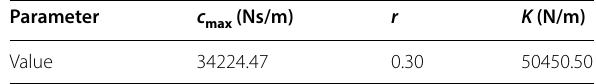
Table 9 The selected buffer parameters Parameter